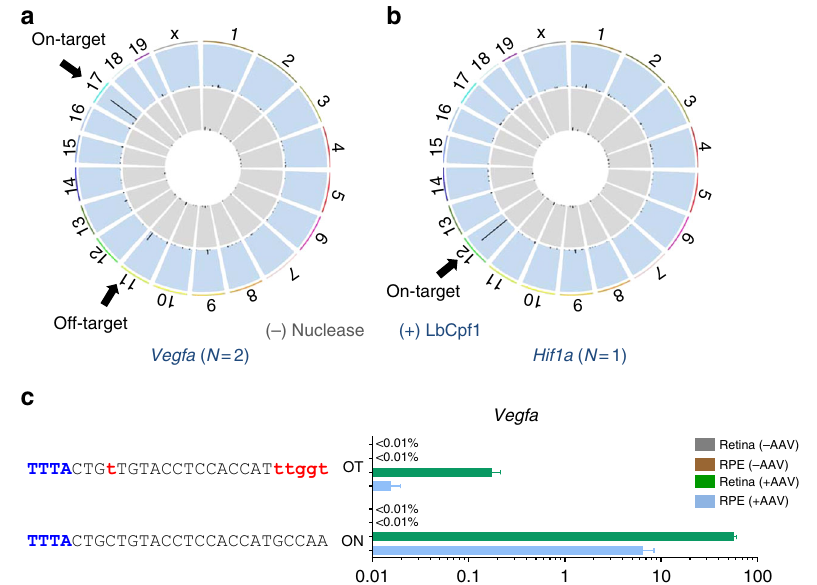
Fig. 2 Retinal genome editing speci fi city of LbCpf1. a , b Mouse genomic DNA isolated from C57BL/6 J mice was digested in vitro by LbCpf1 and its crRNA targeted to Vegfa ( a ) or Hif1a ( b ) and subjected to whole-genome sequencing. Circos plots show genome-wide DNA cleavage scores across the mouse genome. Arrows indicate on-target or off-target sites. N indicates the number of in vitro cleavage sites identi fi ed by Digenome-seq. c Indel frequencies at in vitro cleavage sites identi fi ed by Digenome-seq. Genomic DNA isolated from retina and RPE cells 6 weeks after injection of AAV-Cpf1- Vegfa was subjected to targeted deep sequencing. Mismatched nucleotides are shown in red and PAM sequences in blue. ON, on-target site; OT, off-target site. Error bar indicates s.e.m. ( n =